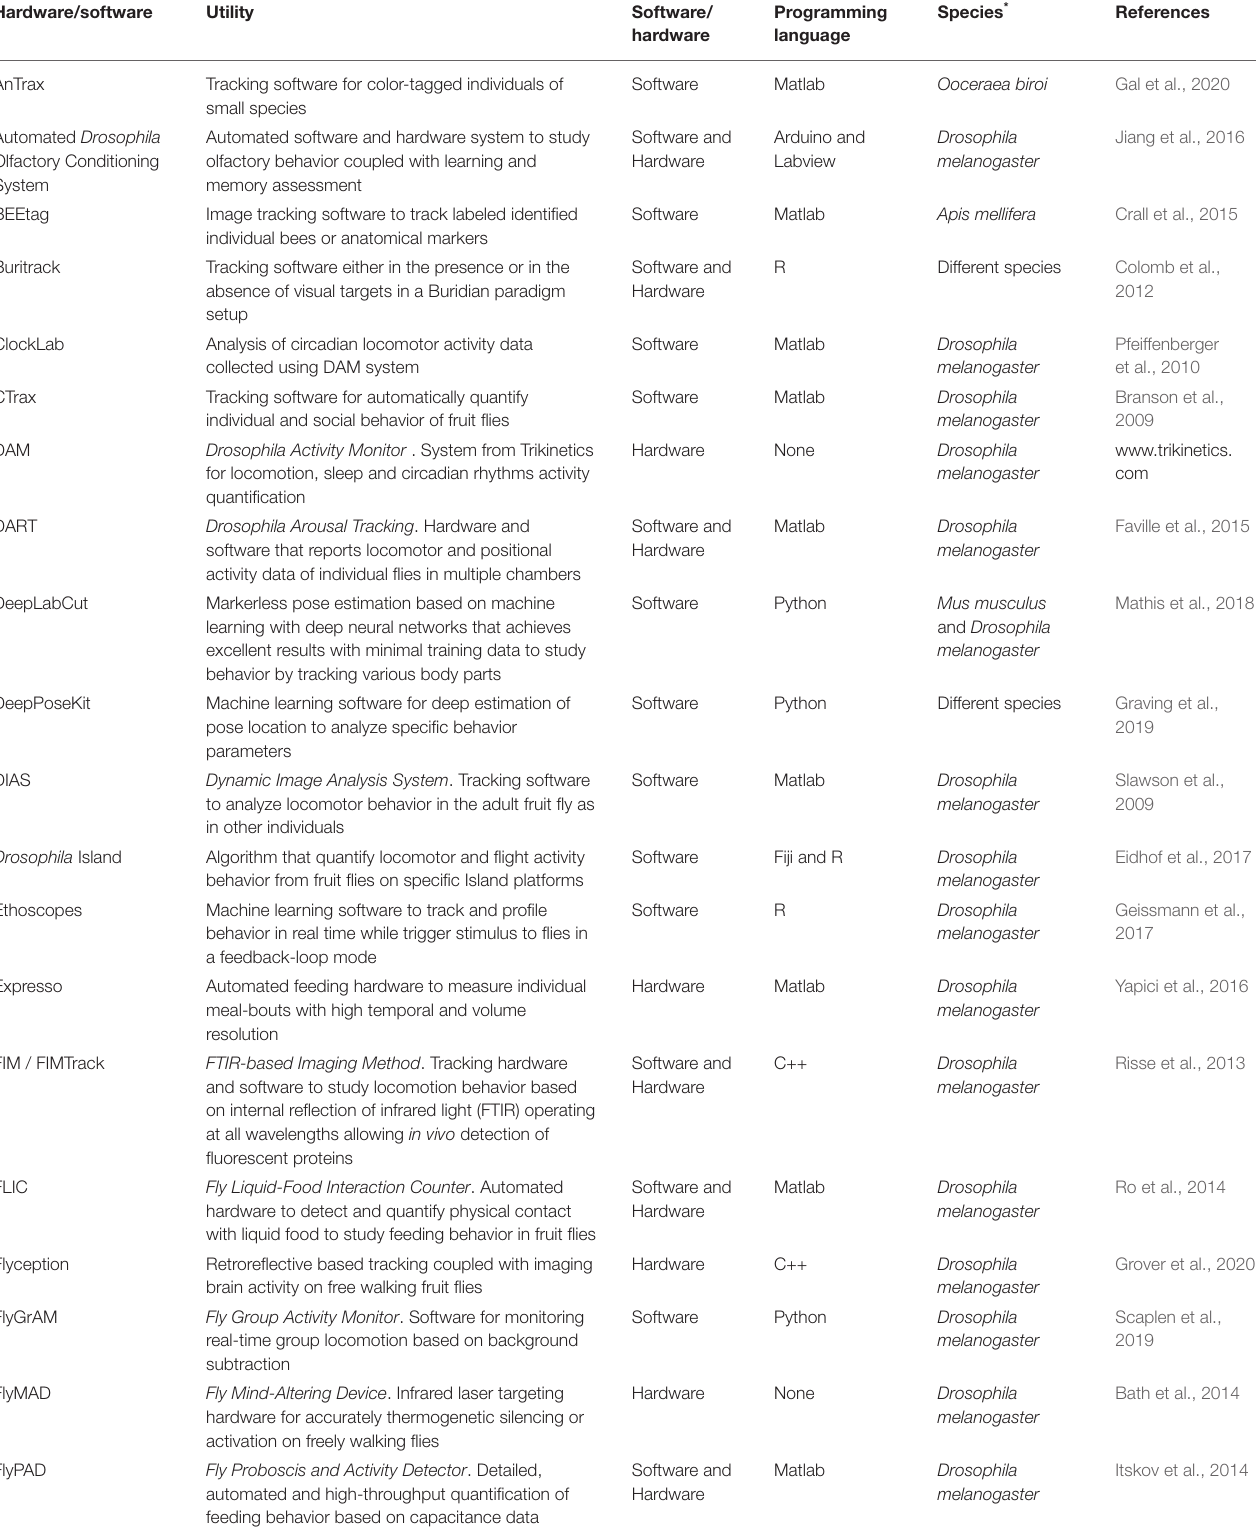
TABLE 1 | Overview of automated and high throughput software and hardware for animal behavior